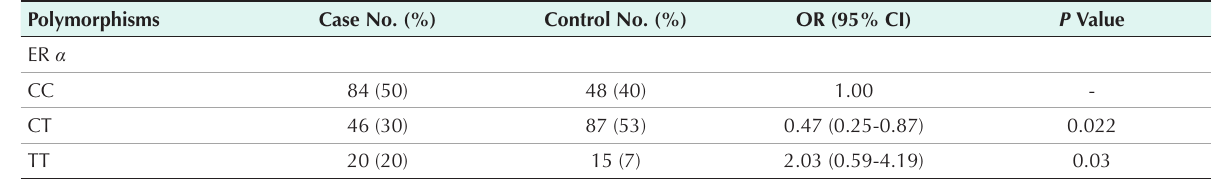
Table 2. The Frequencies of the Genotypes and Alleles of All SNPs in Leiomyoma Patients and Healthy Controls